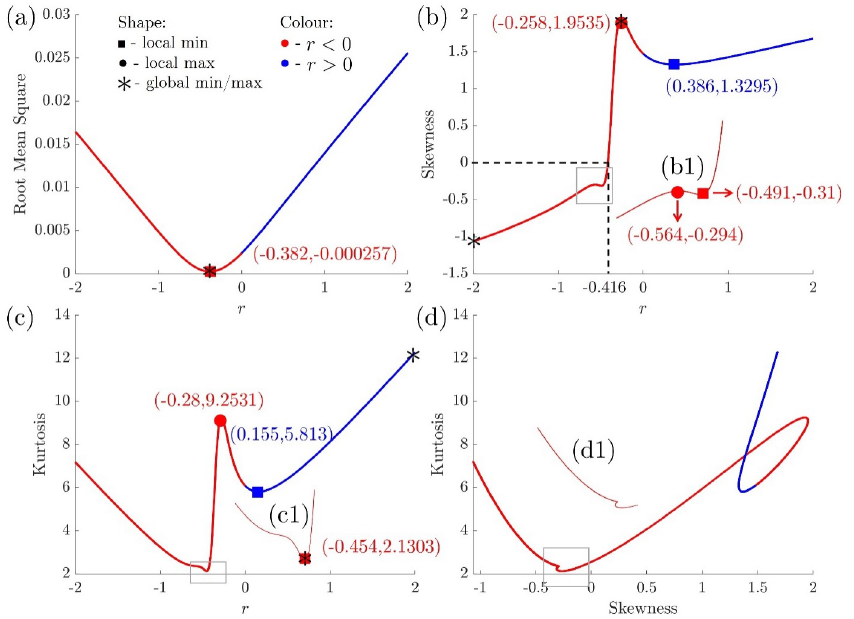
Figure 7. Surface roughness parameters of ¯ h are dependent on the anchoring coefficient ratio r . ( a ) Root mean square (Sq 2 ), ( b ) skewness (Ssk) and ( c ) kurtosis (Sku) are functions of r . ( d ) Sku as a function of Ssk parametrized by r . The red and blue curves demonstrate r < 0 and r > 0, respectively. A square marker represents a local minimum, and a filled circle represents a local maximum. A star marker indicates a global extremum. ( b1 , c1 , d1 ) are the zoom-in details of the region with squares in ( b – d ), respectively.